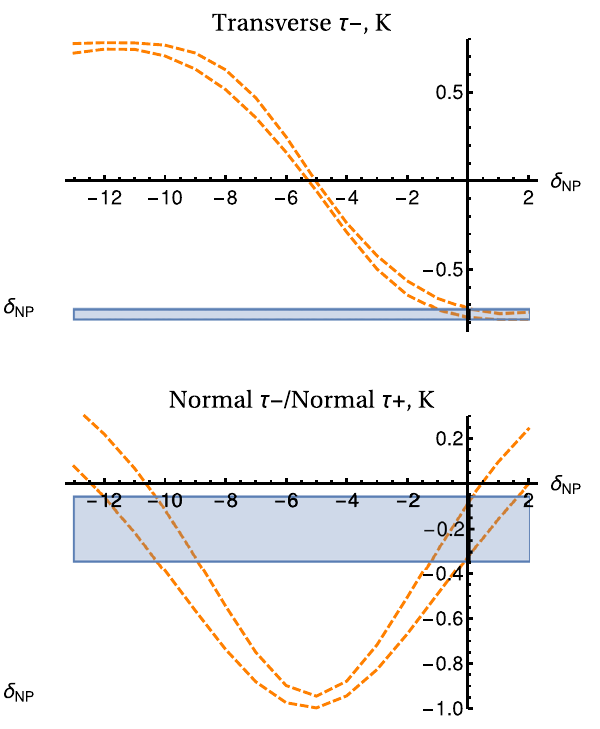
Fig. 7 New physics effects in the form of a real δ C 9 ≡ δ NP , whose values are given in the horizontal axes. The vertical axes give the values of the branching ratio, the transverse polarization of the τ − , and the correlated longitudinal–longitudinal and normal–normal polarizations,